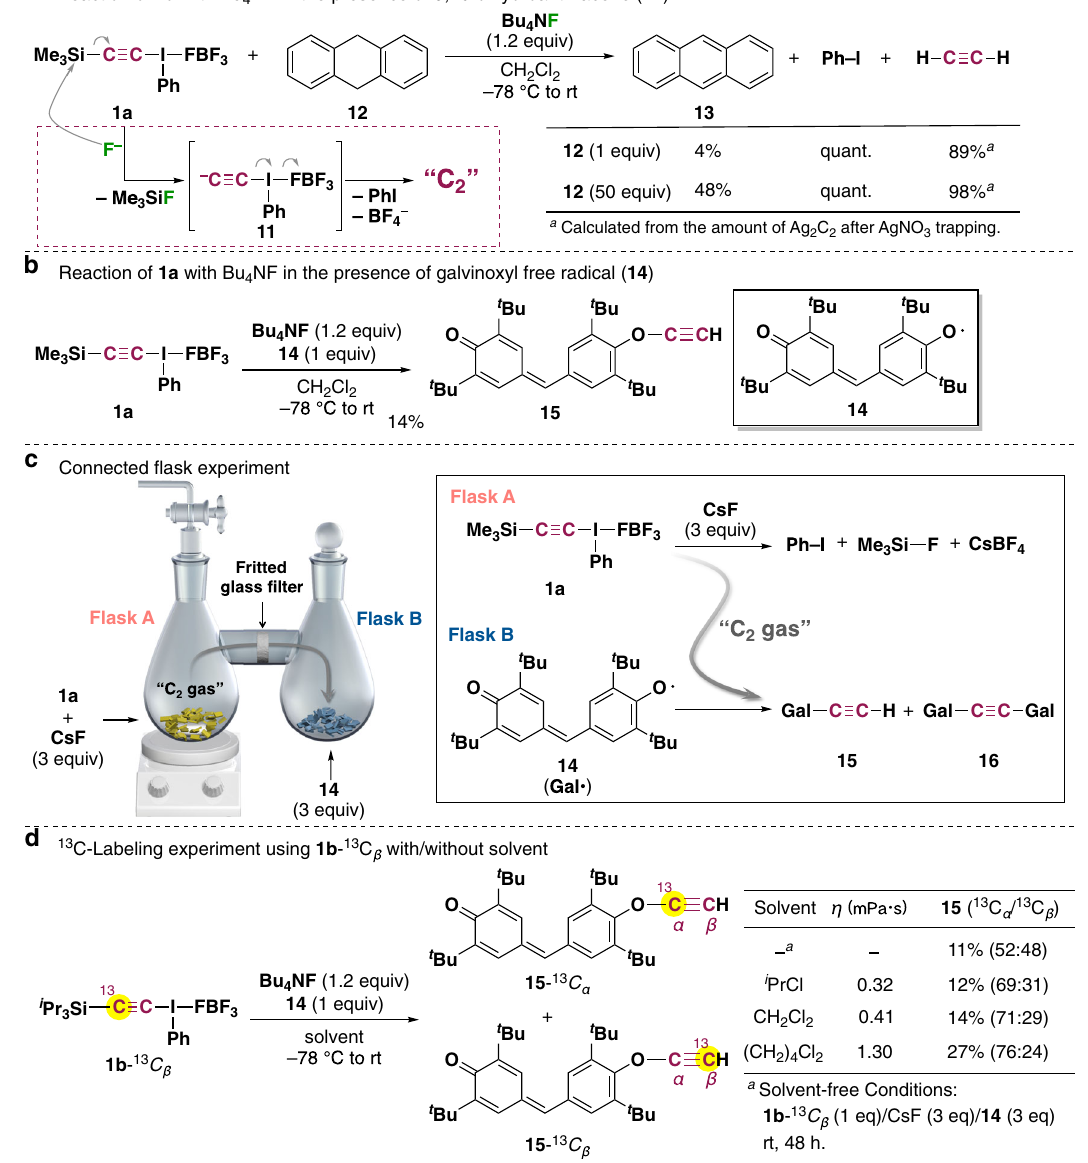
Fig. 2 Chemical trapping of C 2 synthesized at low temperature. a Reaction of 1a with Bu 4 NF in the presence of 9,10-dihydroanthracene ( 12 ). b Reaction of 1a with Bu 4 NF in the presence of galvinoxyl free radical 14 . c Connected- fl ask experiment. d 13 C-Labeling experiments using 1b - 13 C β